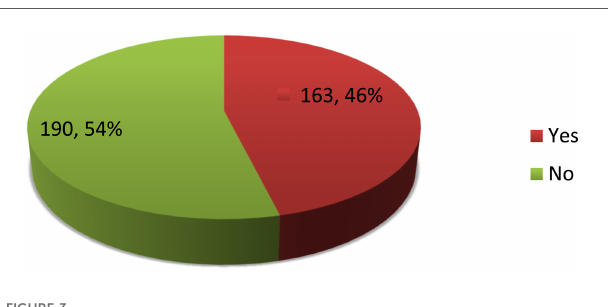
FIGURE 3 Overall prevalence of GBV among female Wolkite University students, southwest Ethiopia,